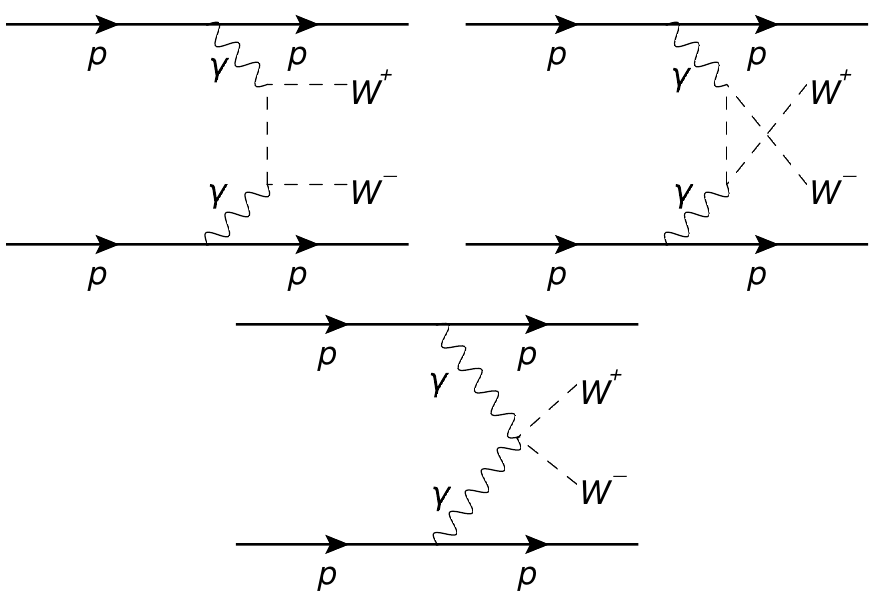
Figure 1 . Leading order SM diagrams contributing to pp → pW + W − p . The upper two diagrams represent the t - and u -channels contribution induced by the SM γW + W − coupling, whereas the lower diagram corresponds to the SM γγW + W − coupling in the